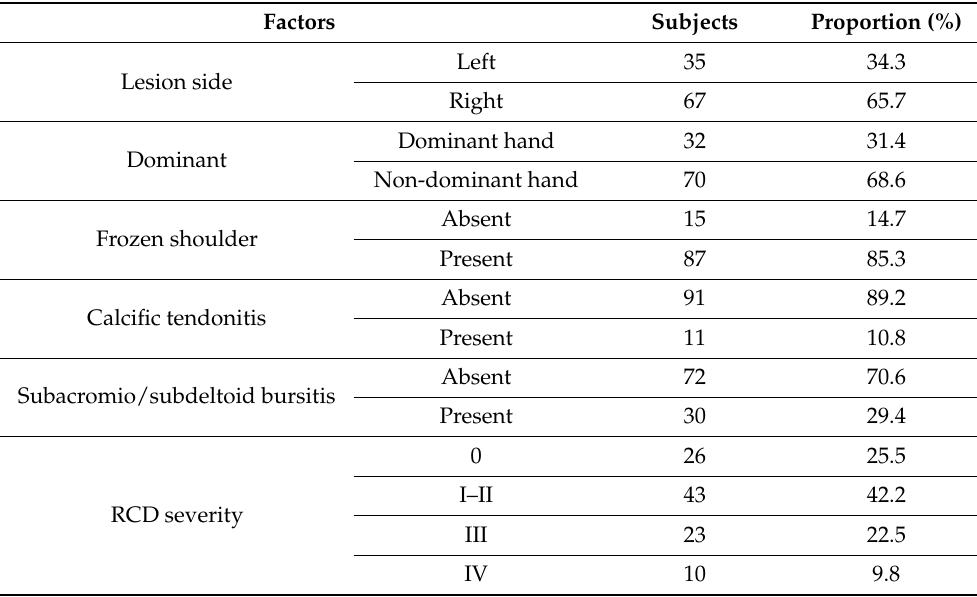
Table 2 lists the descriptive analysis of the independent variables. Table 2. Descriptive analysis of each factor confirmed by ultrasonography ( n =